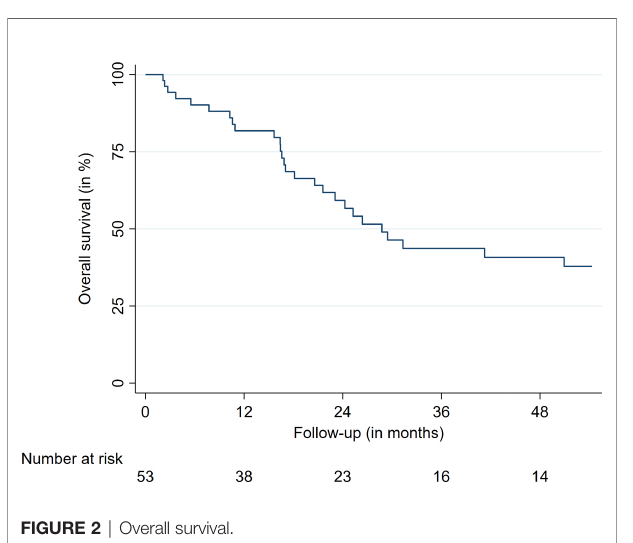
FIGURE 4 | Local progression-free